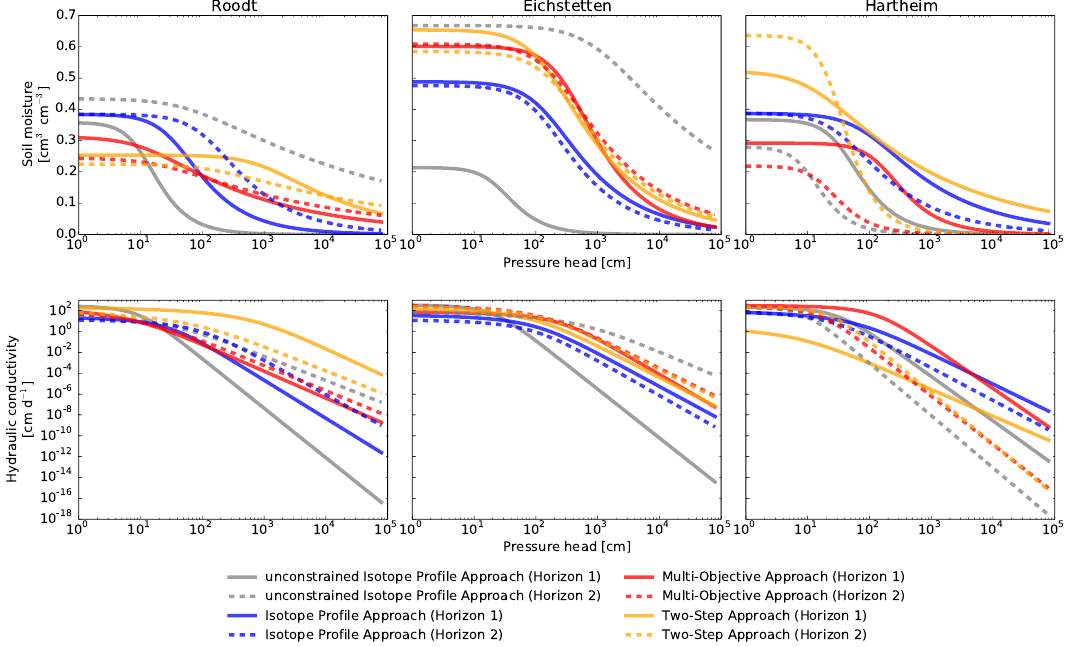
Figure 4. The water retention and the hydraulic conductivity functions for the parameter sets of the upper and lower soil horizons (contin- uous and dashed line, respectively) that resulted in the best model performance after calibrating with the three different inverse modelling approaches for each study site. Note that with respect to these characteristic curves the three calibration approaches are based on only isotope data (uIPA), a mix of isotope data and soil texture data (IPA), a mix of isotope and soil moisture data (MOA) and only soil moisture data